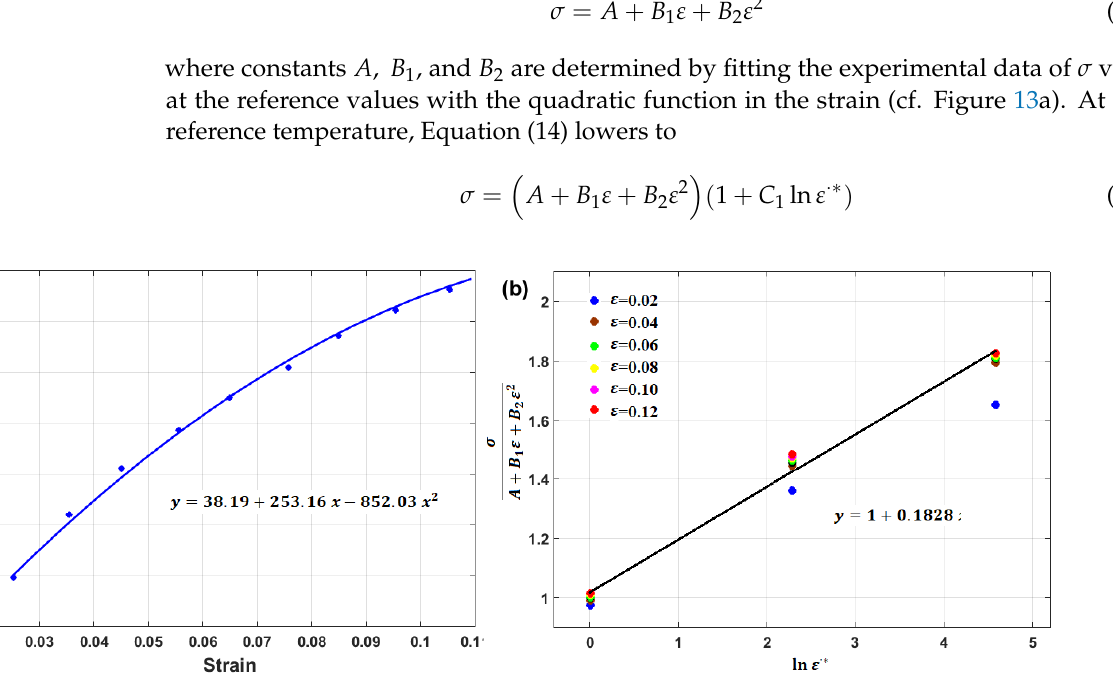
1 , and B 2 and ( b ) C 1